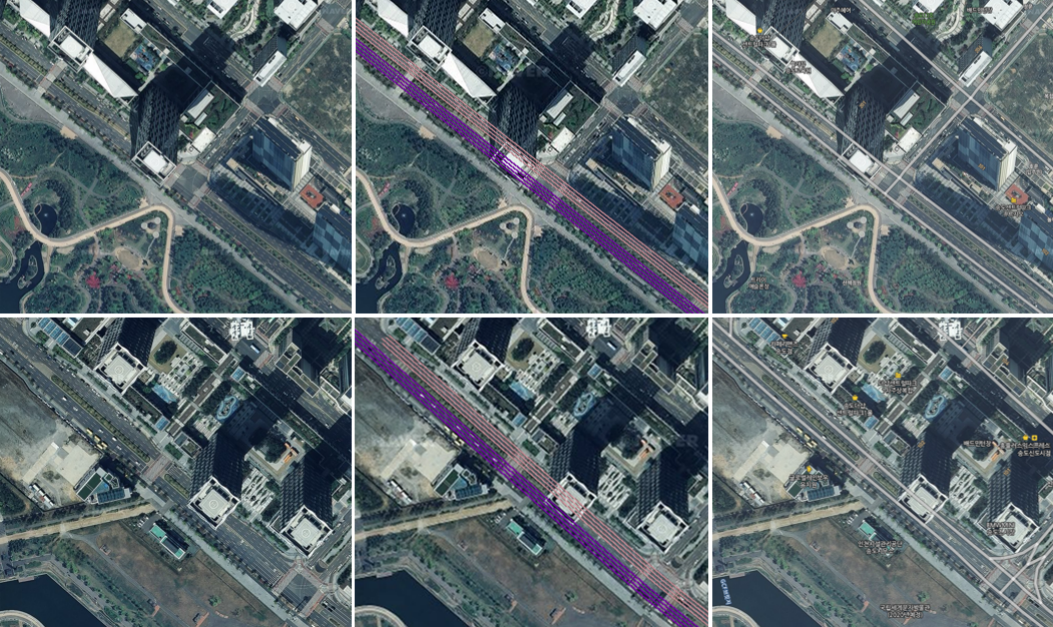
Figure 6. More results of the detected road lanes on Route 2 are accumulated to generate a lane-level digital map with the help of a GPS/INS sensor. The left column shows the satellite images, the middle column the resulting lane-level map overlapped with the satellite images and the right column the existing road-level map provided by Naver Map